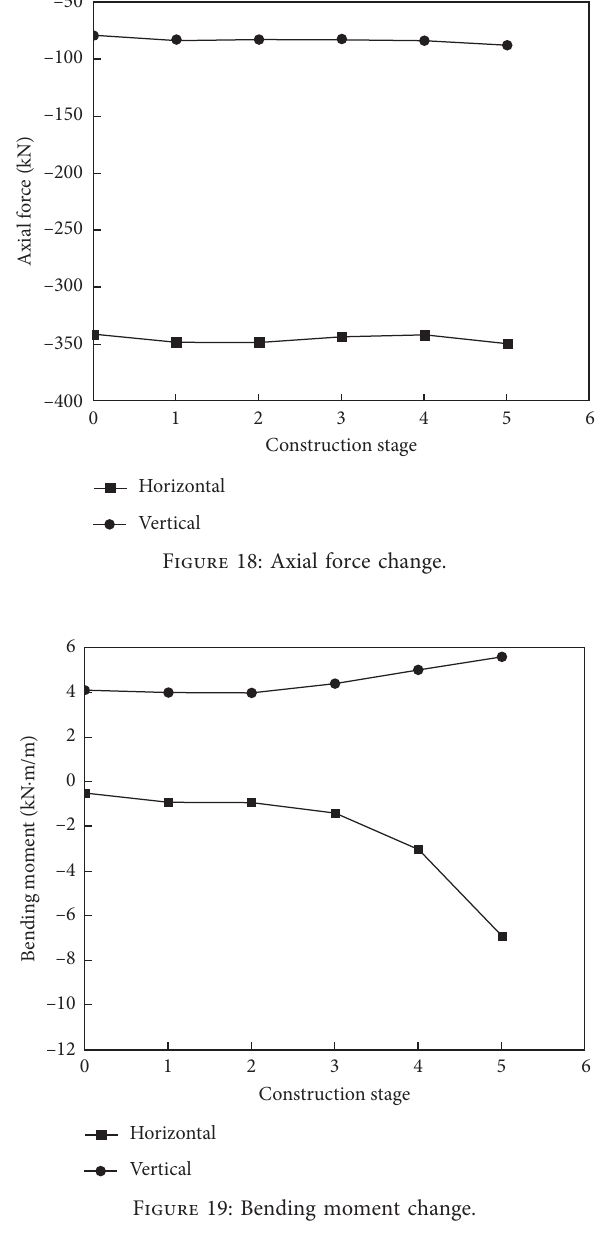
Figure 19: Bending moment